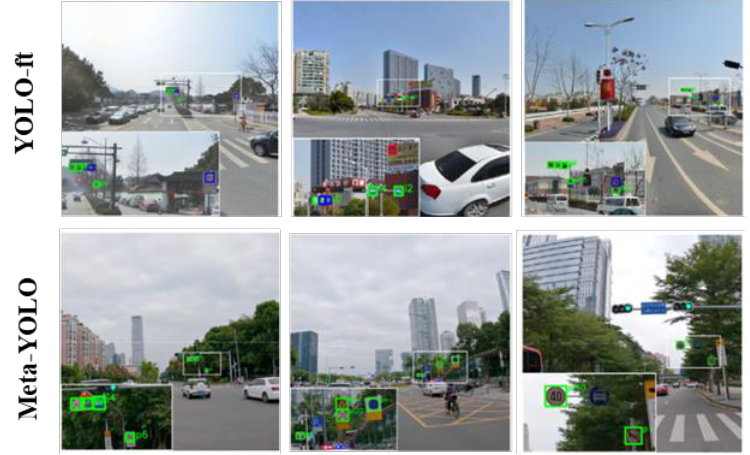
Figure 6. The visualization of novel class traffic signs by YOLO-ft and Meta-YOLO. Comparing with Meta-YOLO, YOLO-ft is inferior: b-boxes in the first columns are omitted; in the middle column they are wrong; in the last columns they are almost duplicated.